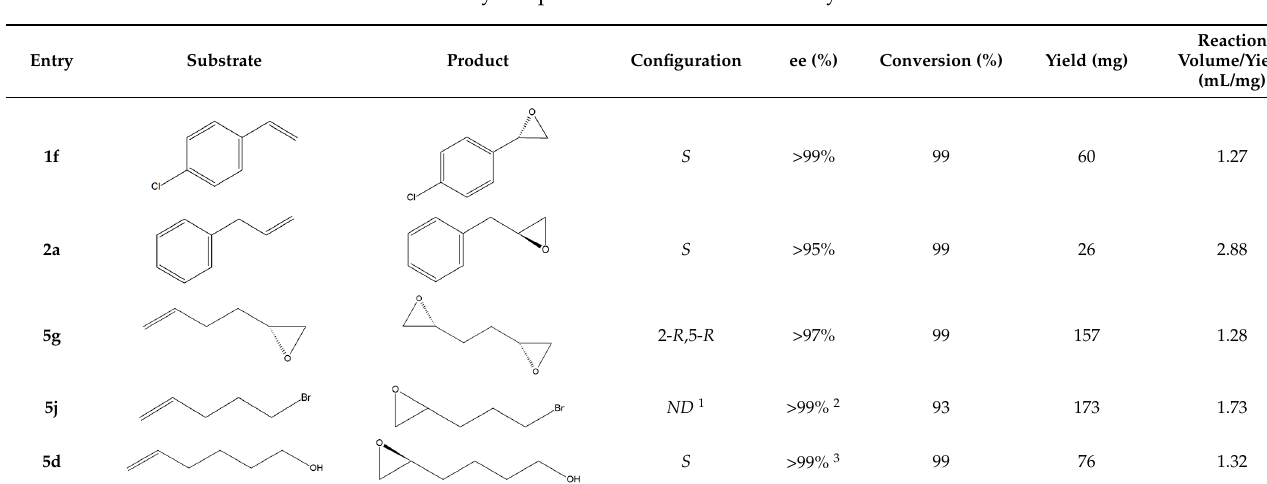
Table 3. Summary of upscaled biotransformations by whole-cell SMO.